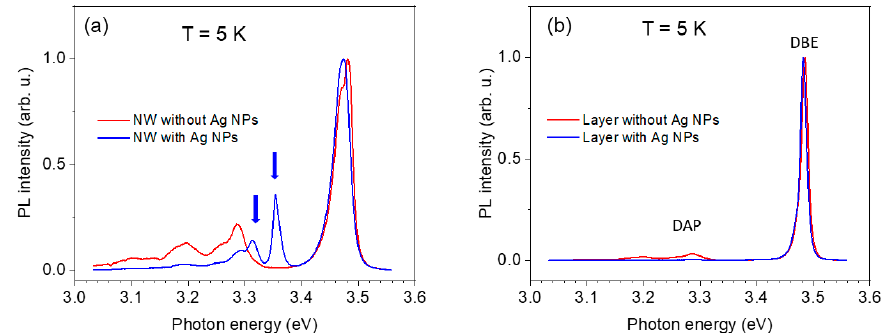
Figure 2. ( a ) Normalized time-integrated PL spectra taken at 5 K for bare GaN NW (red line) and for the hybrid Ag NPs/GaN NW structure. ( b ) Reference PL spectra taken at 5 K for the GaN layer without (red line) and with (blue line) Ag NPs.